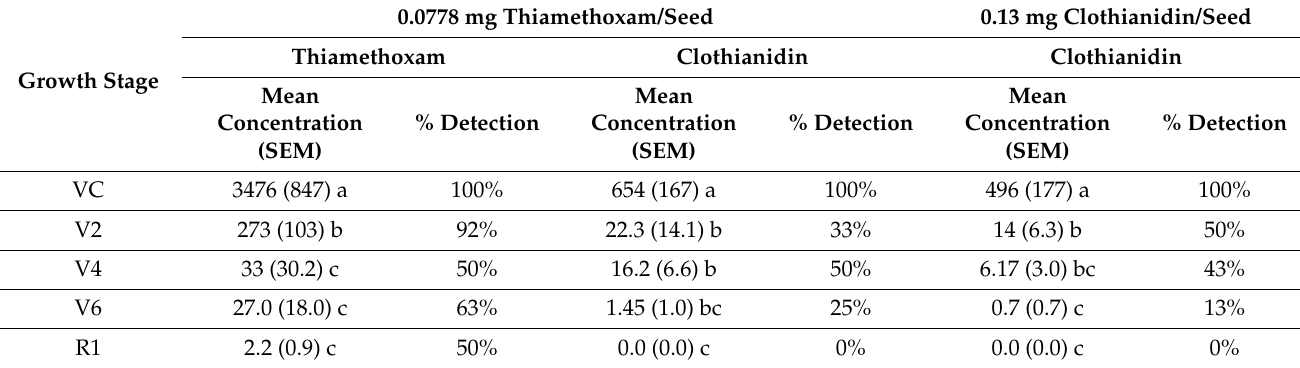
Table 3. Mean concentrations (ng/g) and percent detection of neonicotinoids detected in soybean leaf tissue from plots con- taining the thiamethoxam seed treatment (thiamethoxam 0.0778 mg/seed) and the clothianidin seed treatment (clothianidin 0.13 mg/seed) at each sampled growth stage across all